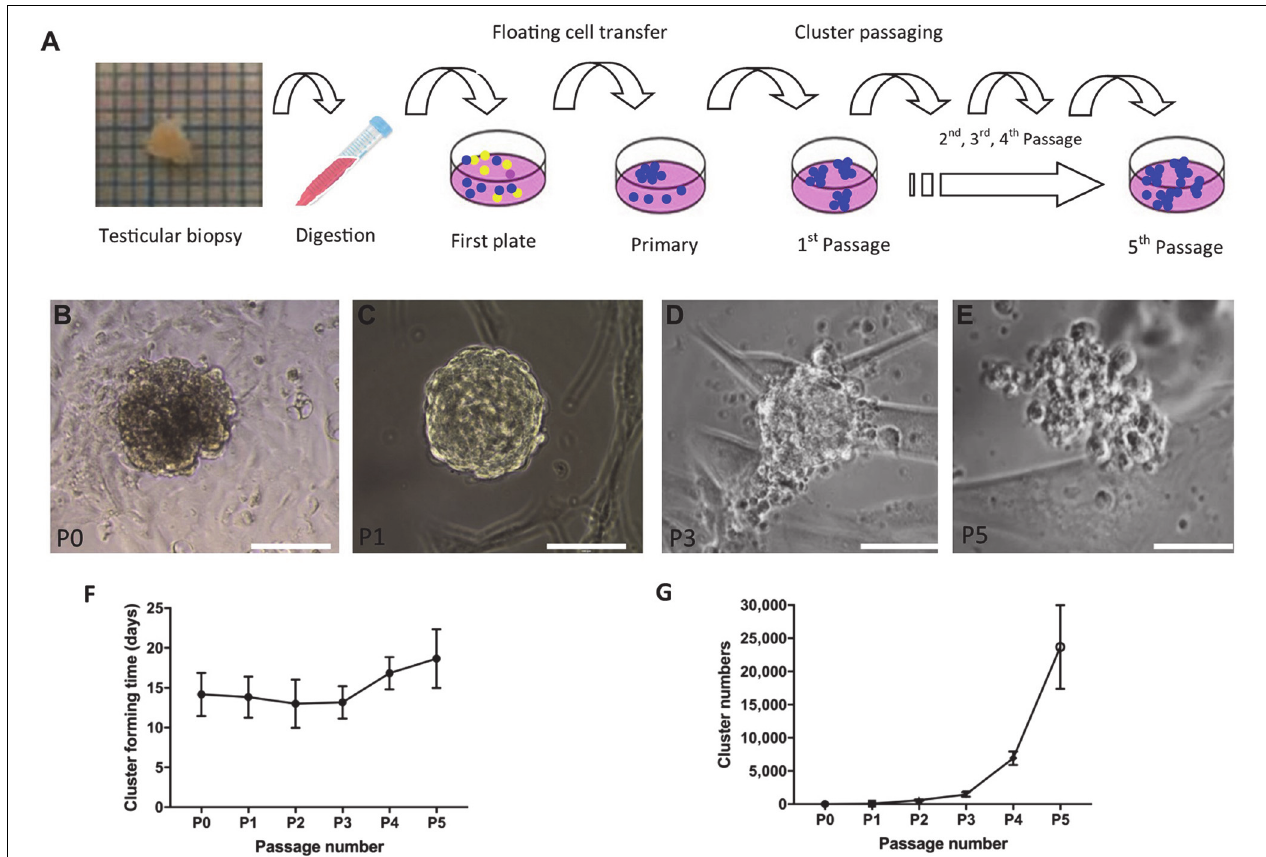
FIGURE 3 | Derivation and propagation of human spermatogonial stem cell like cell clusters (SSCLCs) from infant boys. (A) , Methodology of deriving SSCLCs from testicular biopsies. One square is 1 mm 2 . (B) , SSCLCs forming from primary cell culture. (C) , First passage. (D) , Third passage. (E) , Fifth passage. Scale bar 100 µ m. (F) , Cluster forming time after passaging (mean and standard deviations). (G) , Estimated SSCLC numbers (mean and standard deviations).